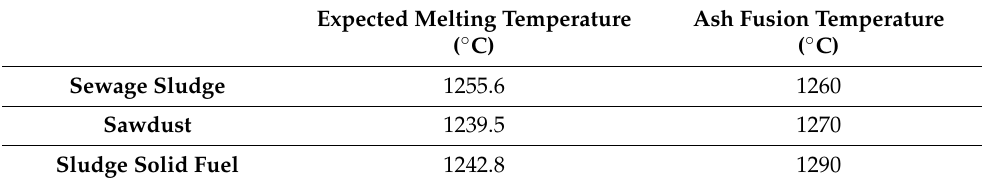
Table 5. Comparison of the melting temperature prediction and analysis results.